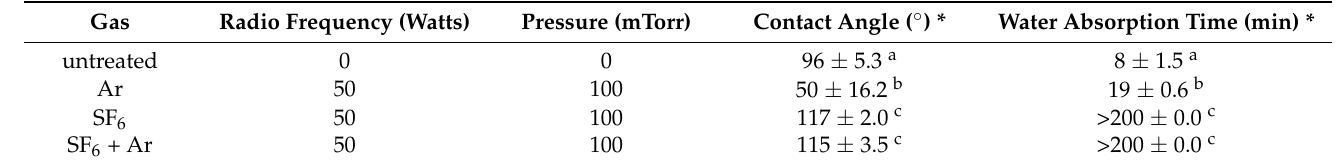
Table 1. Effect of argon and sulfur hexafluoride gas on the contact angles of untreated and treated KP with plasma at 100 mTorr, 50 Watts, and 5